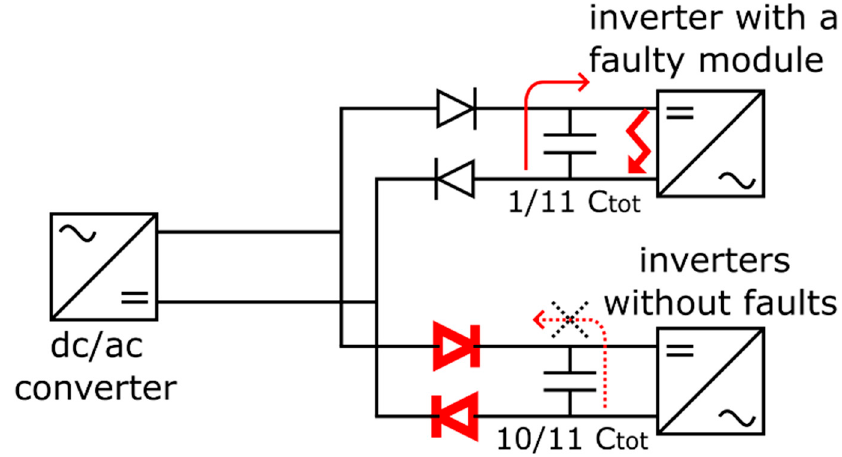
Figure 4. Principle of operation of the decoupling diodes.